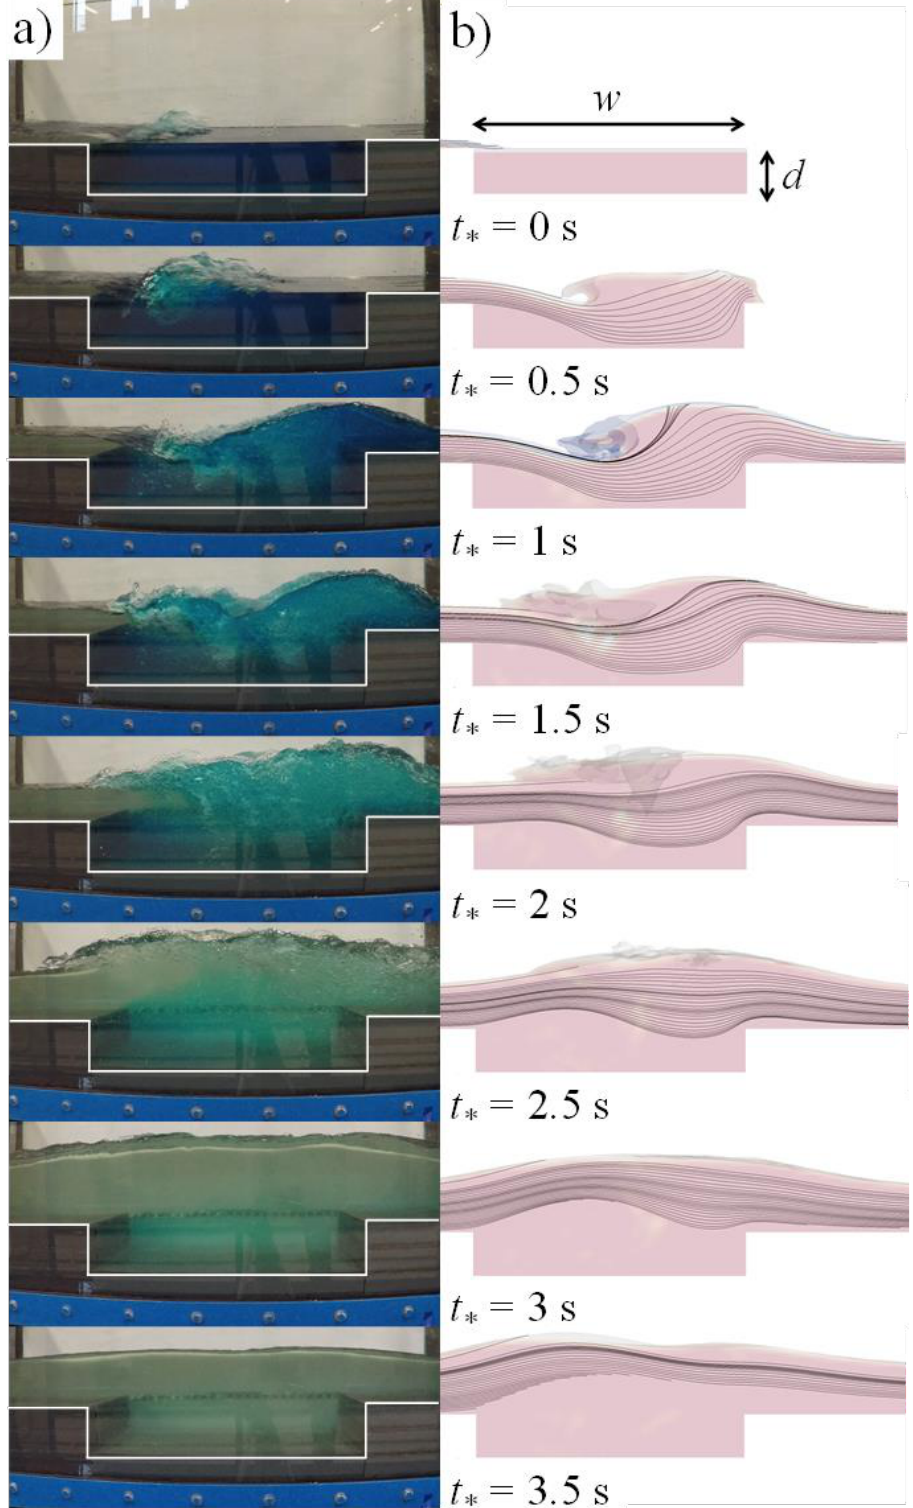
Figure 8. Time history of water surface profiles of a bore from an impoundment with a depth of d o = 0.3 m, passing over a canal with a width of w = 0.6 m and a depth of d = 0.10 m: ( a ) side-view images; ( b ) simulated water surface profile and streamlines.